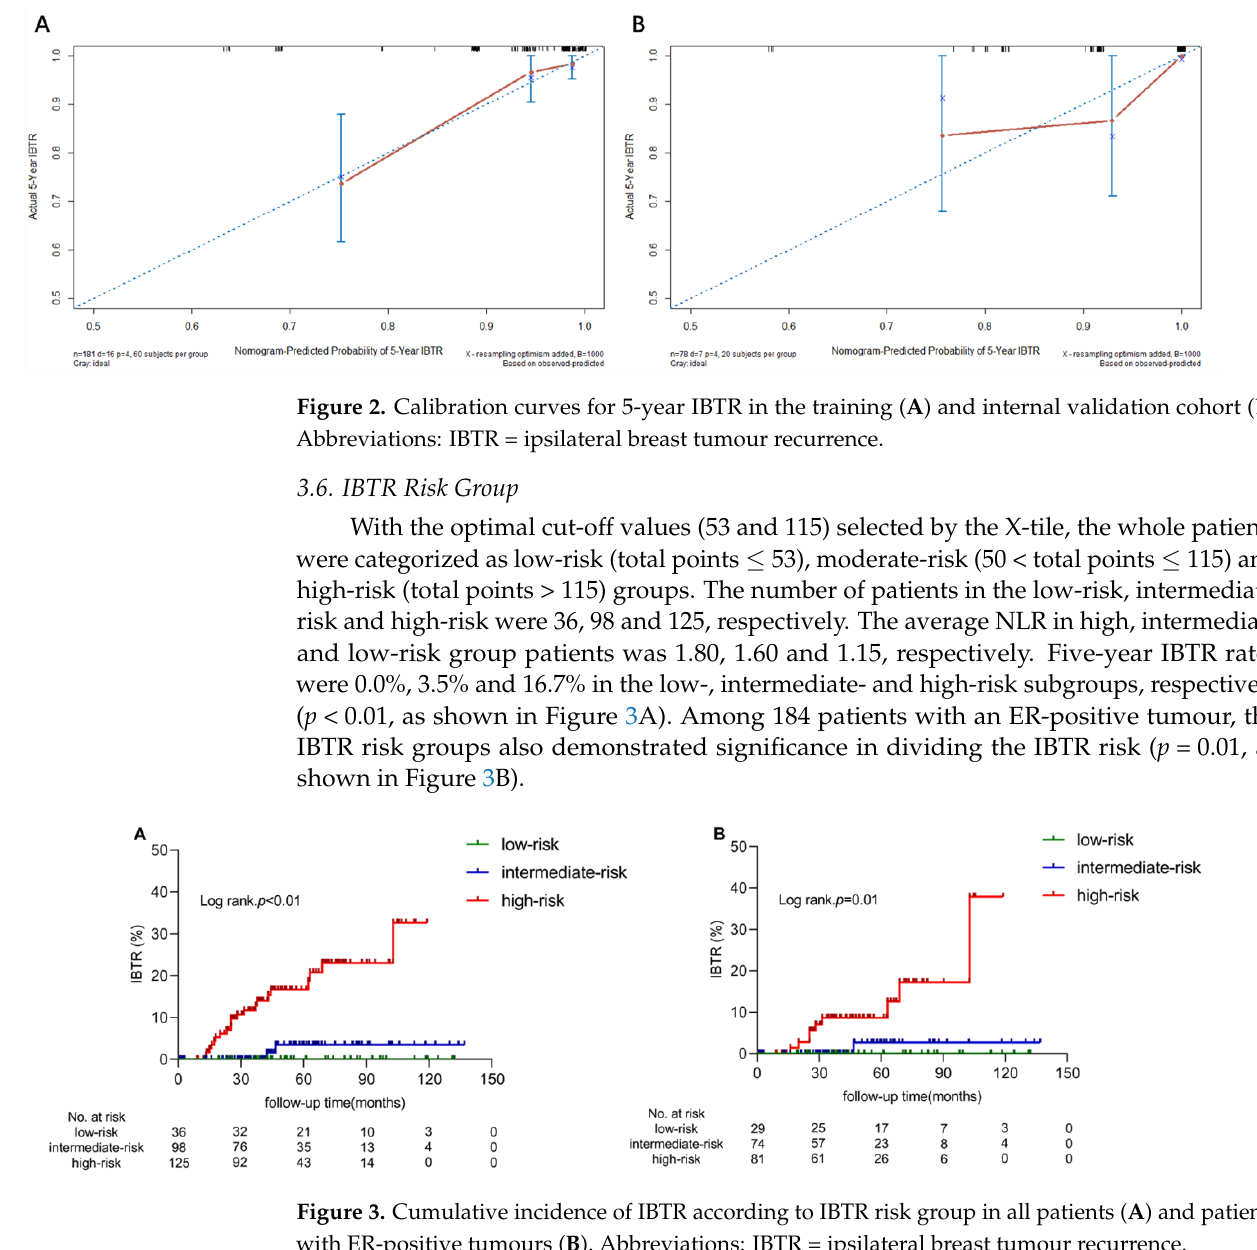
Figure 3. Cumulative incidence of IBTR according to IBTR risk group in all patients ( A ) and patients with ER-positive tumours ( B ). Abbreviations: IBTR = ipsilateral breast tumour recurrence.